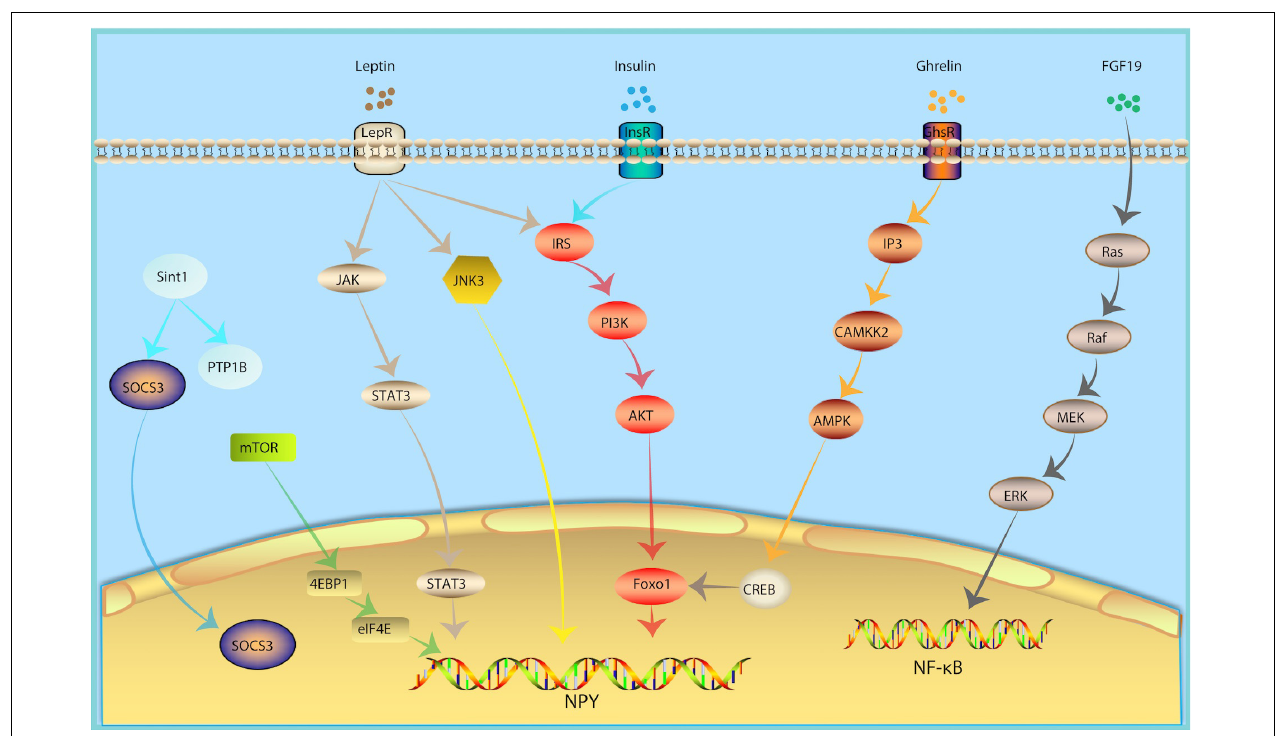
FIGURE 2 | Molecular Mechanism of NPY Neurons in Metabolism Regulation. In response of peripheral metabolic changes, metabolic hormones including leptin, insulin and ghrelin regulated NPY signal via JAK-STAT3, PI3K-AKT-Foxo1, IP3-CAMKK2-AMPK pathway, respectively. FGF19, fibroblast growth factor-19; growth hormone secret agogue receptor (GHSR); InsR, insulin receptor; inositol triphosphate (IP3); JAK, Janus kinase; JNK, Jun NH2-terminal kinase; LepR, leptin receptor; mammalian target of rapamycin